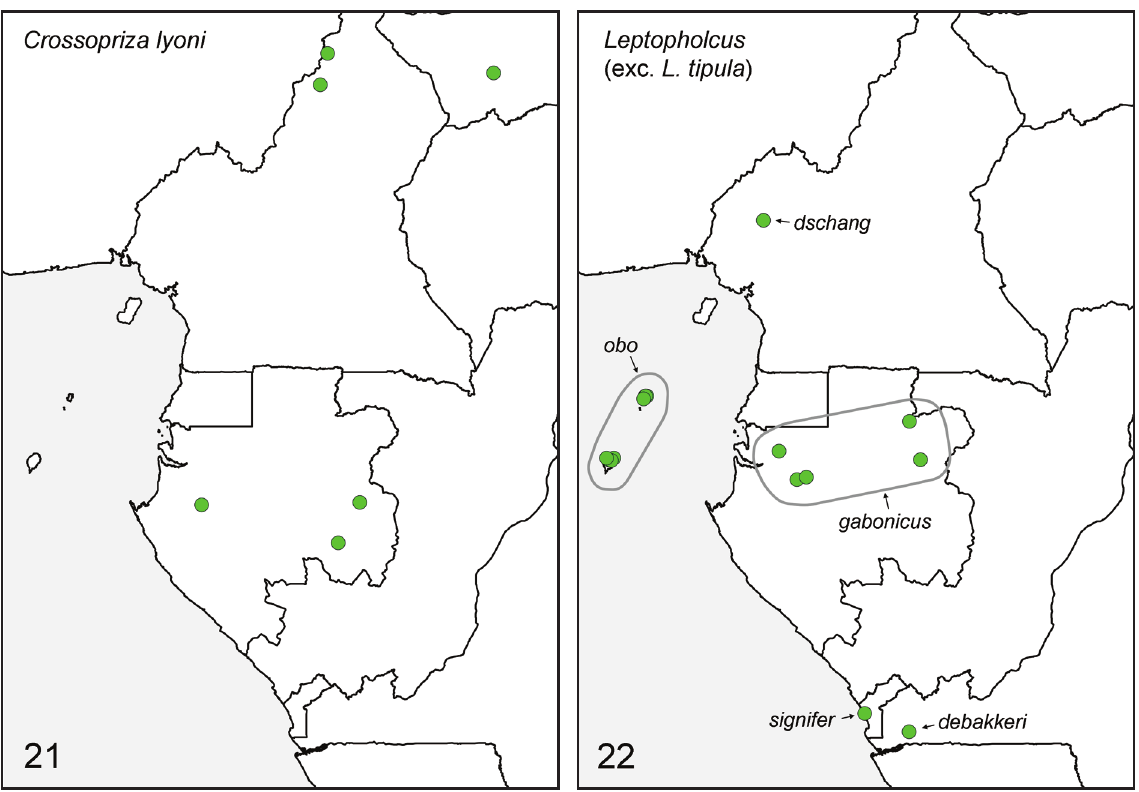
Figs 21-22. Known distributions of Crossopriza lyoni (Blackwall, 1867) and of the genus Leptopholcus Simon 1893 [except L. tipula (Simon, 1907); see Fig. 23] in Central